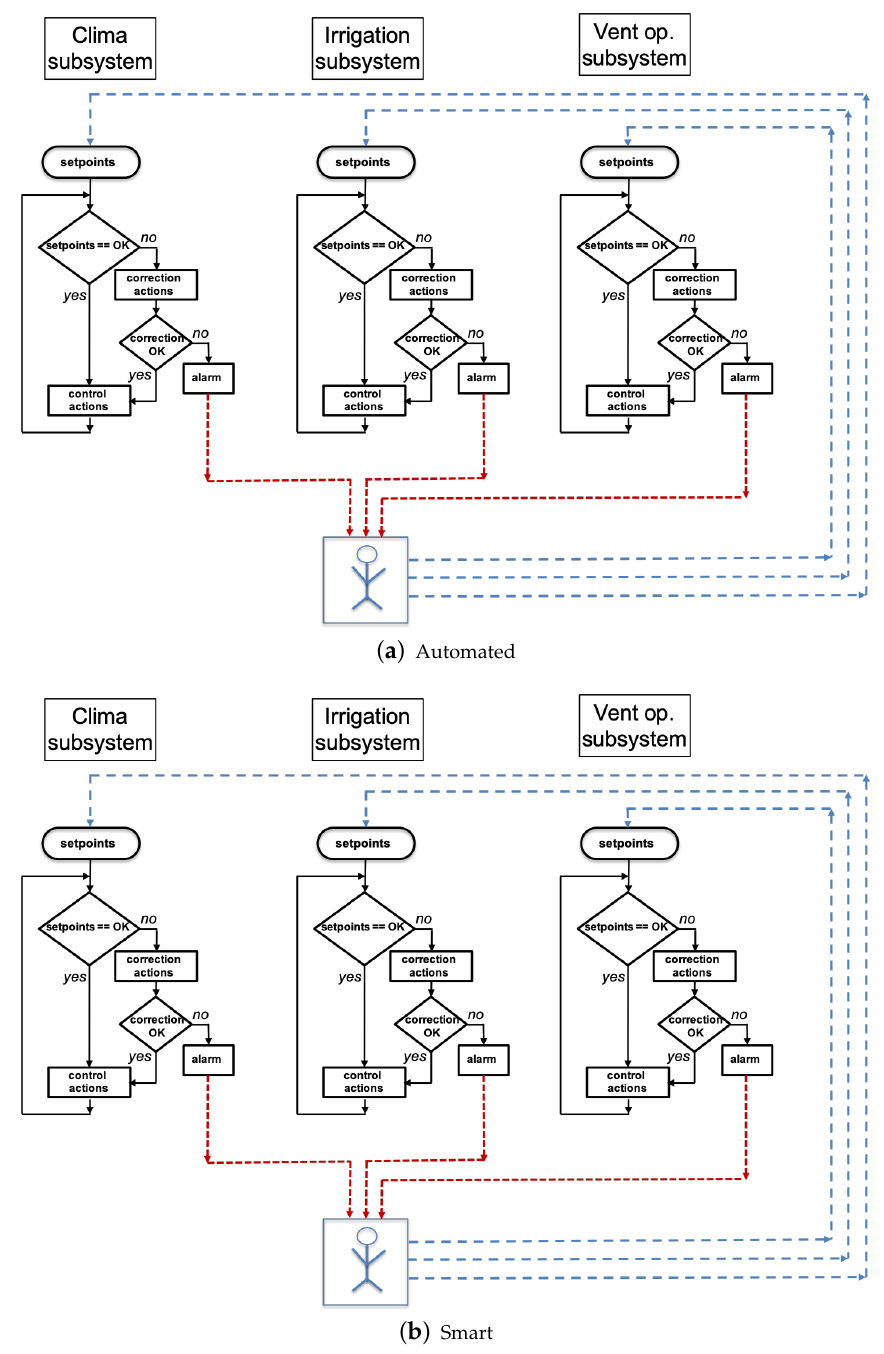
Figure 1. The sub-image automated represents a current automated system, where the agronomist manages the setpoints (control variables). The sub-image smart shows the proposal of this work, where an artificial intelligence platform detects and acts automatically, introducing prediction and optimization services that are supervised by the